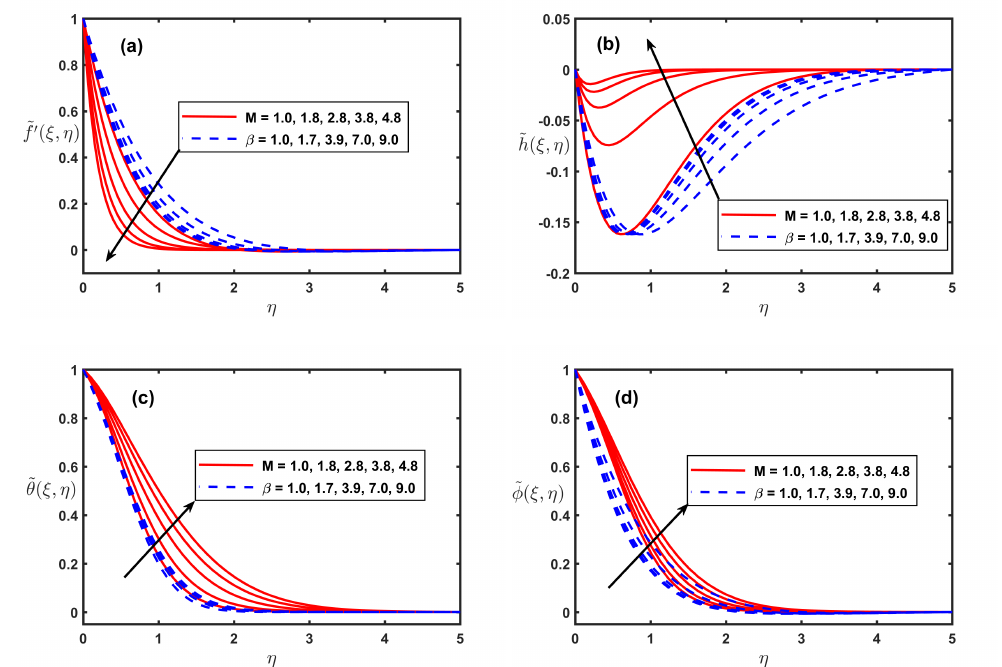
Figure 4. Fluctuation of ˜ f (cid:48) ( ξ , η ) , ˜ h ( ξ , η ) , ˜ θ ( ξ , η ) , and ˜ φ ( ξ , η ) along with M and β